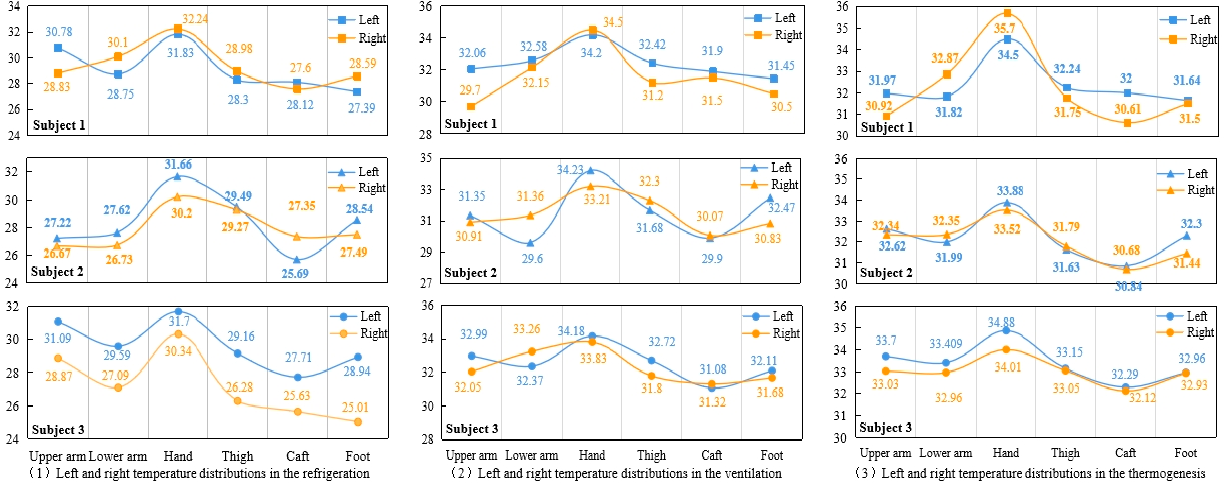
Figure 16. The temperature differences between left and right body parts observed under different ventilated conditions while wearing long